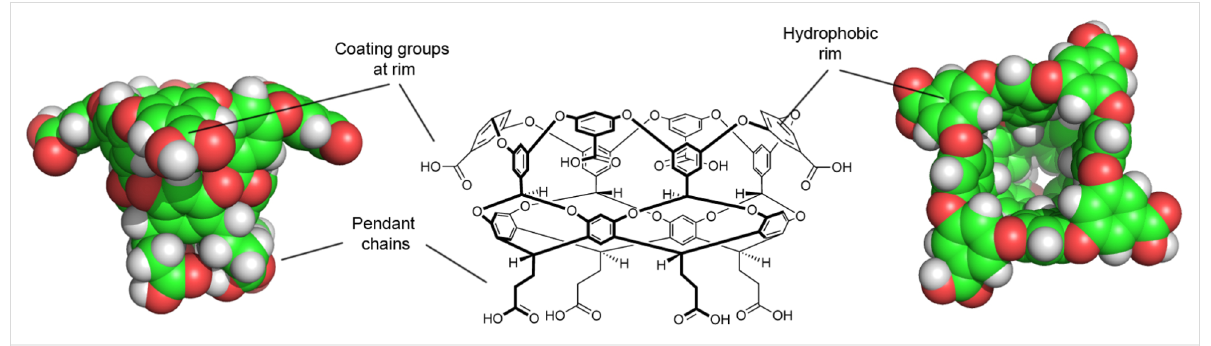
Figure 5: (Center) Chemical structure of the octa-acid host. (Left and right) Respective space-filling representations of octa-acid showing side and plan views.